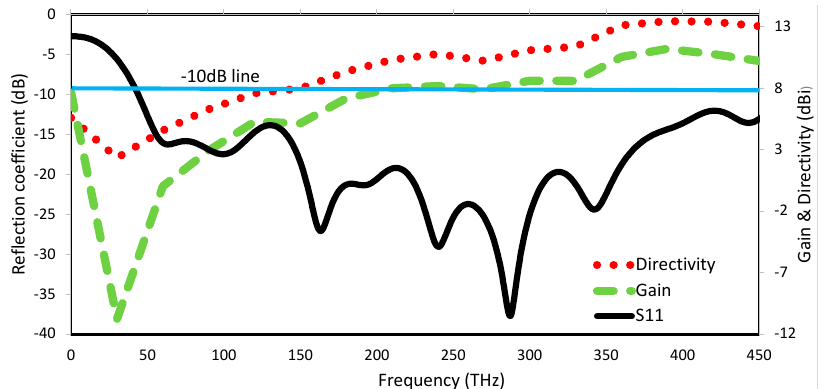
Figure 5. S 11 and gain of the antenna versus frequency in THz covering all of the three main optical windows.